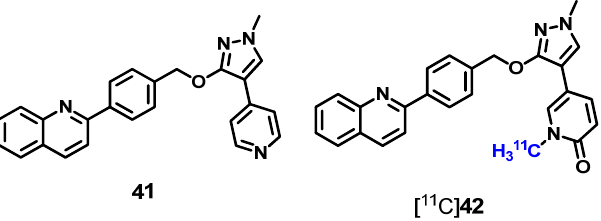
Figure 7. Molecular structures of PDE10A inhibitor 41 and the 11 C-labeled derivative thereof for PET.